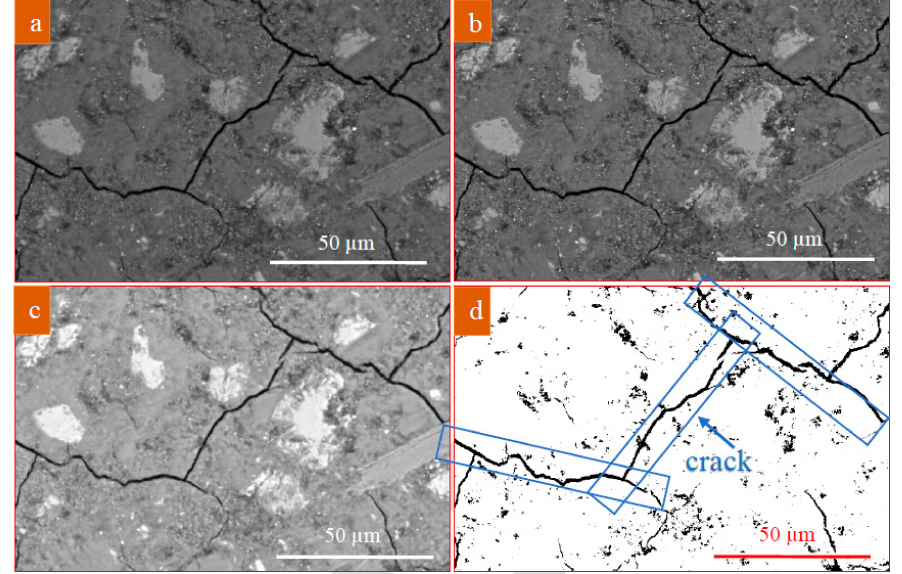
Figure 1. ( a ) A representative SEM micrograph; ( b ) the noise reduced image; ( c ) the adjusted grayscale image; and ( d ) the binary